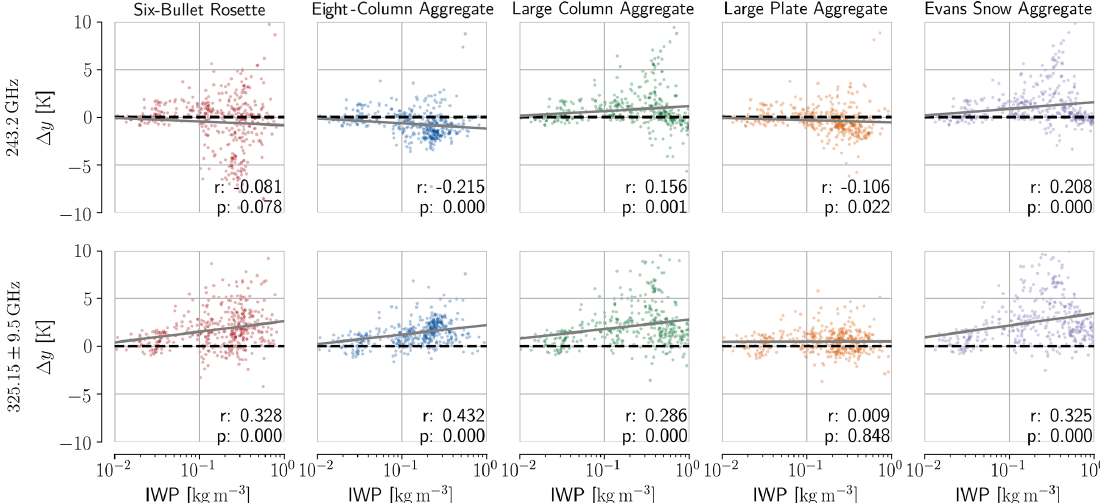
Figure 15. Brightness temperature residuals between true and simulated observations for two channels from flight B984. The first row shows the results for the 243 ± 2 . 5GHz channel, while the second row shows the results for the 325 ± 9 . 5GHz channel. Columns show the results for the five tested particle shapes. The grey line in each panel represents the regression line for the plotted data points. The text displays the correlation coefficient r and the p value of a two-sided significance test for the slope of regression